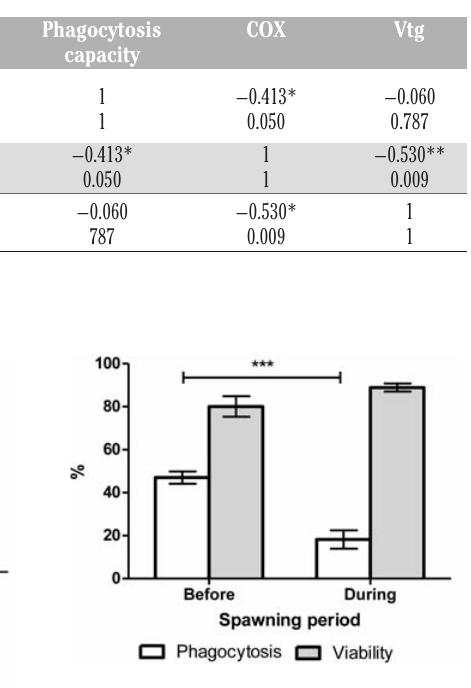
Figure 2. Phagocytic capacity and viability of hemocytes from Mytilus edulis before and during spawning period.